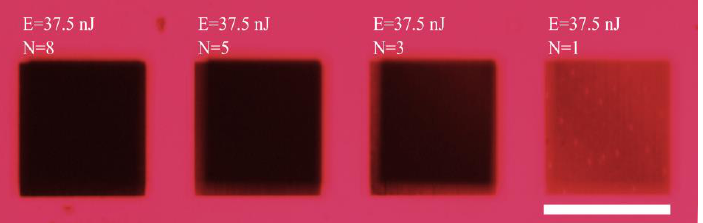
Figure 3. Dependence of crater diameter on pulses of energy E = 5.8, 8.4, 15.8, and 23.4 nJ and numbers of pulses N= 1, 3, 5, 8. For each energy, four diameter values corresponding to pulse numbers N = 1, 3, 5, and 8 are given (from bottom to top).